Question: Write the caption for this figure.
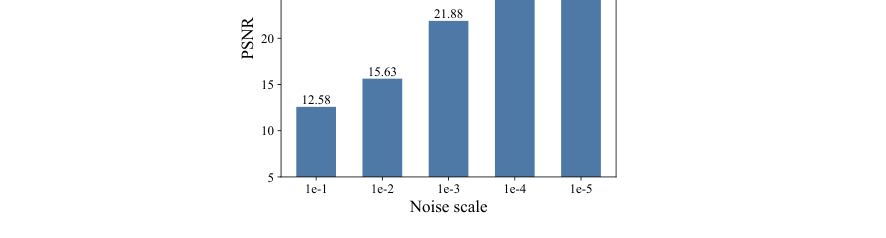
Answer: The effect of GI-SMN against the differential privacy defense. The hori- zontal axis indicates the level of noise added to the gradient information.